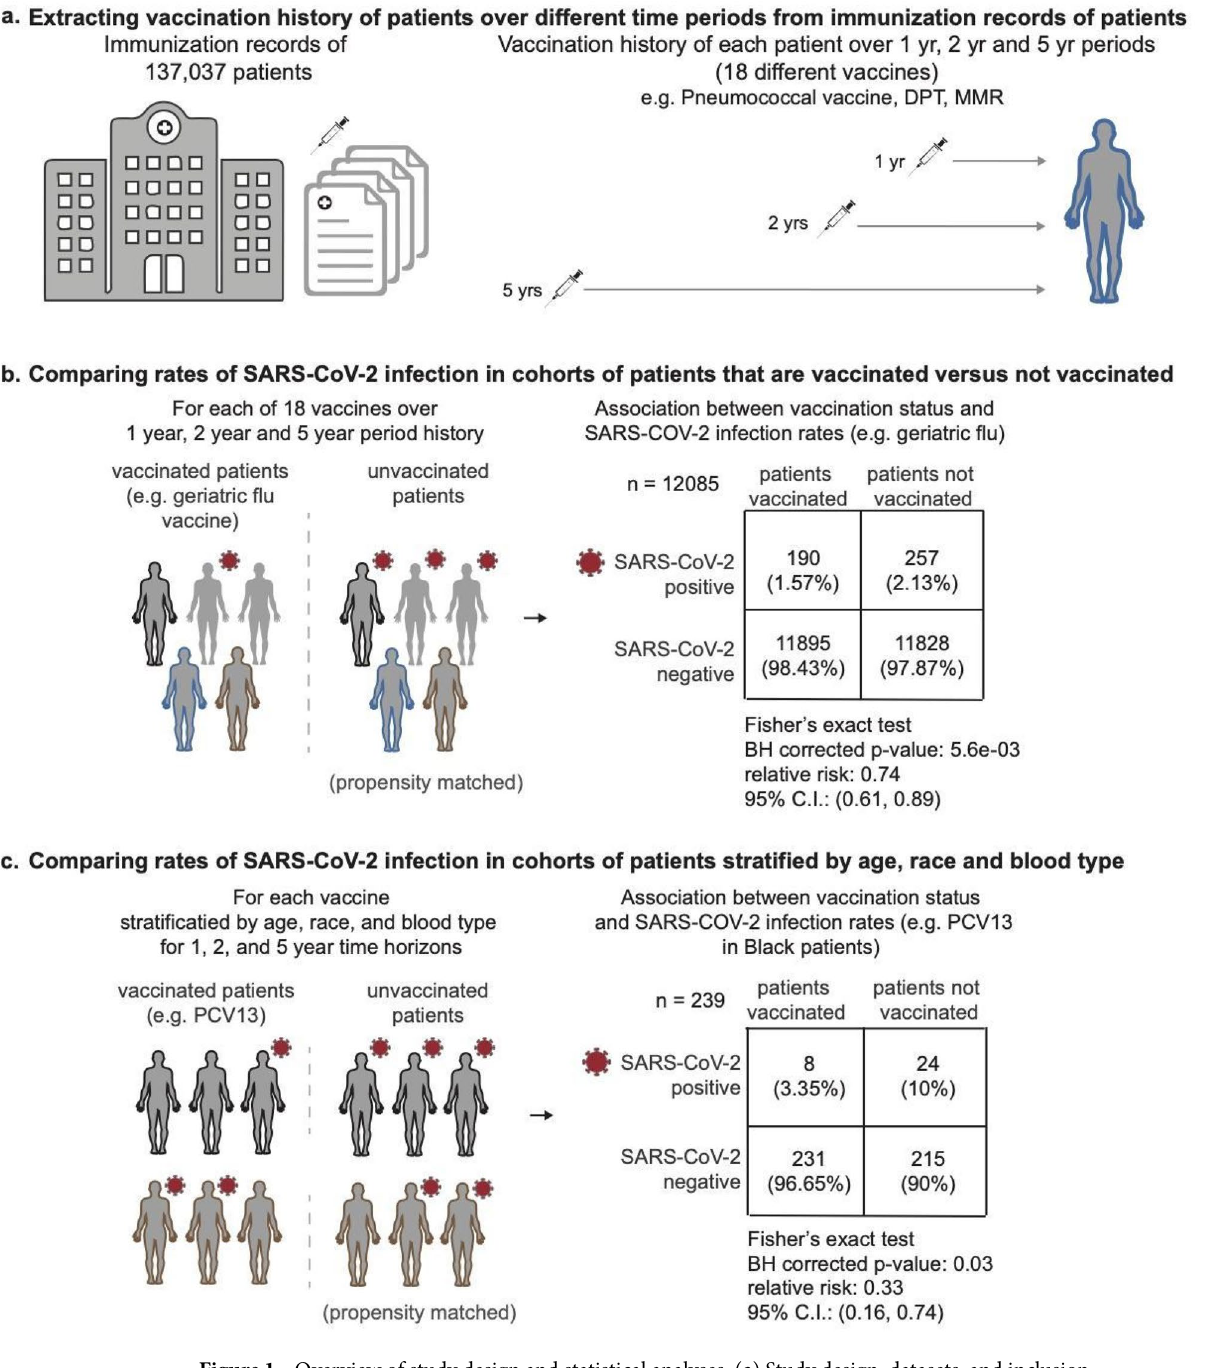
Figure 1. Overview of study design and statistical analyses. ( a ) Study design, datasets, and inclusion criteria used for the study; ( b ) comparisons of SARS-CoV-2 rates between propensity-matched vaccinated and unvaccinated cohorts in the overall study population; ( c ) comparisons of SARS-CoV-2 rates between propensity-matched vaccinated and unvaccinated cohorts in subgroups of the population stratified by age, race/ ethnicity, and blood